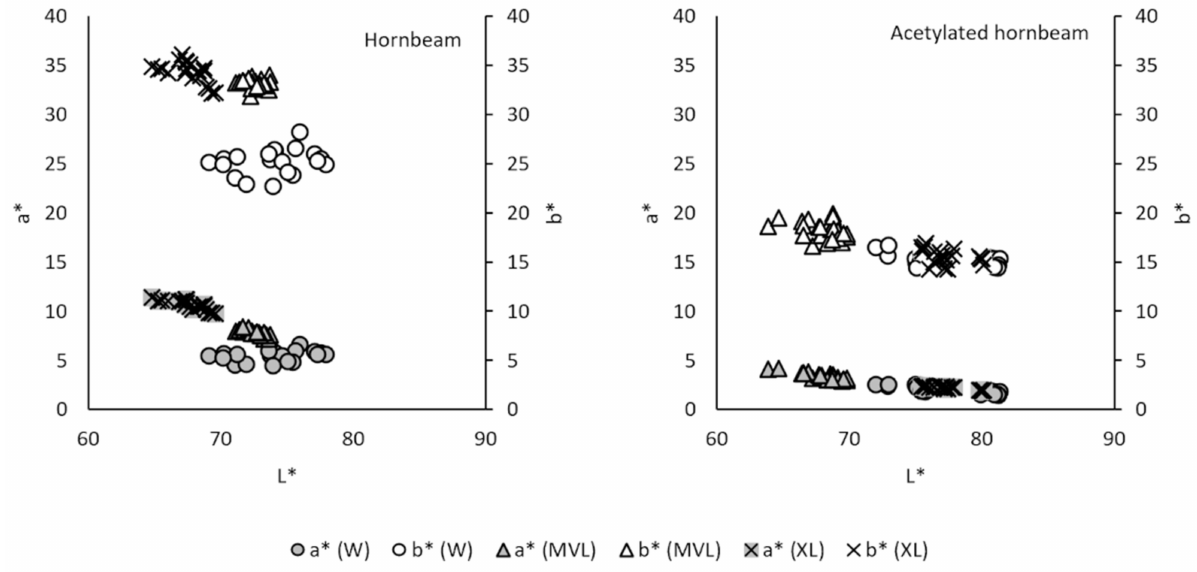
Figure 14. Comparison of color change (L*: lightness, a*: red hue, b*: yellow hue) of uncoated hornbeam and acetylated hornbeam caused by different photodegradation processes (W: weather, XL: xenon lamp, MVL: mercury-vapor